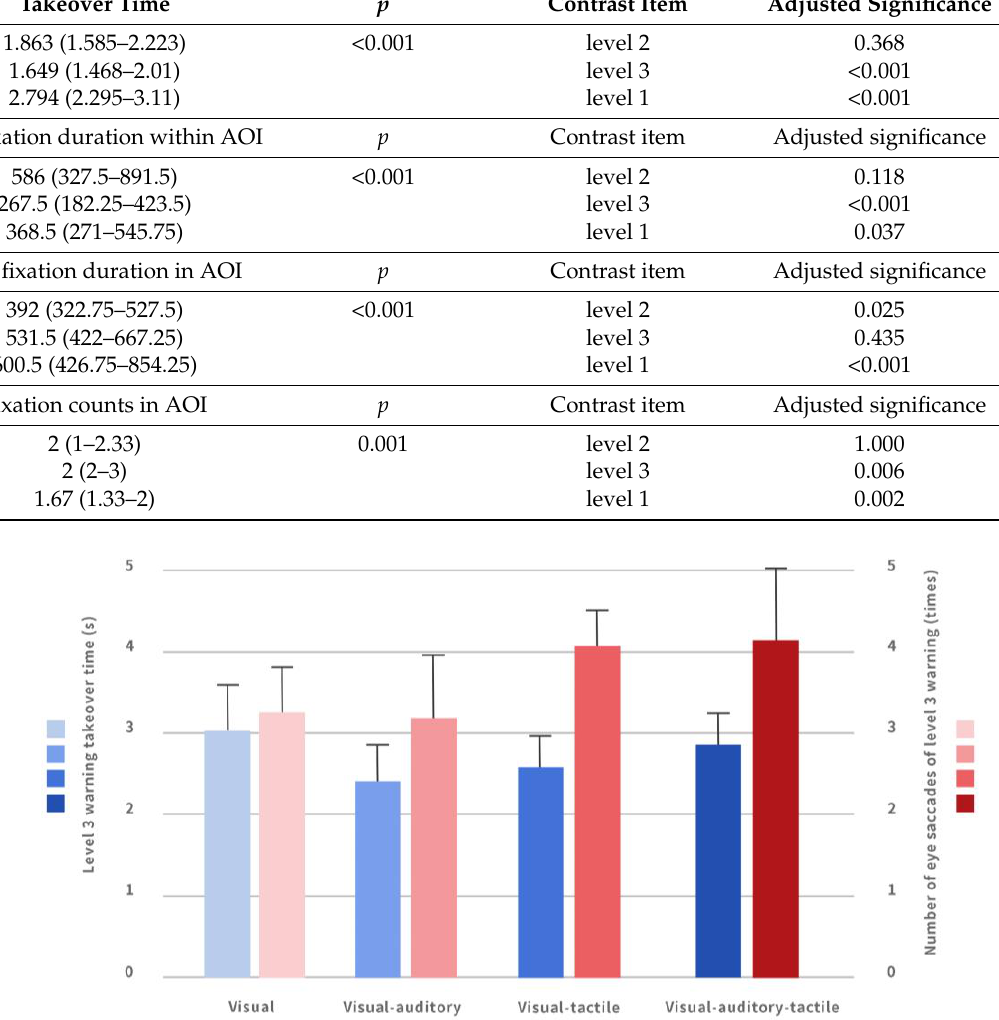
Table 3. Comparison of the takeover time, first fixation duration in AOI, total fixation duration in AOI, and the fixation count points in AOI under different warning levels and pairwise comparison.